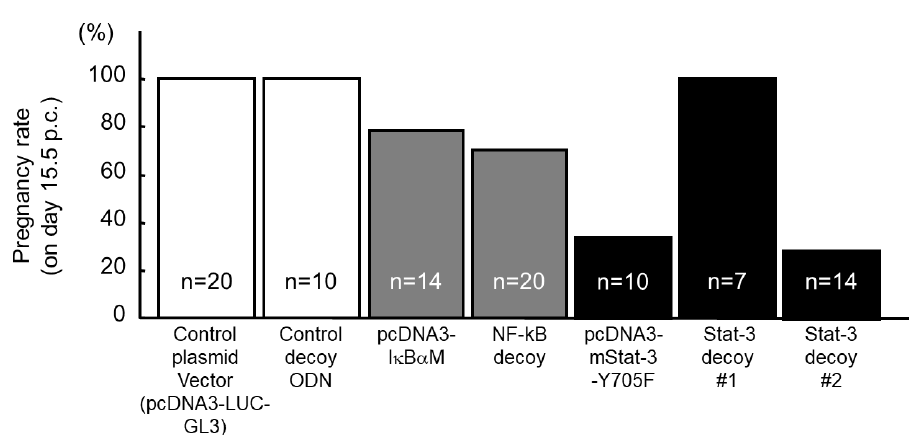
Figure 3. Effect of gene transfer in mouse uterus using HVJ-E vector on pregnancy rate. The dominant negative mutant of NF- κ B (pcDNA3-I κ B α M), the dominant negative mutant of Stat-3 (pcDNA3-Stat-3-Y705F), or double-stranded decoy ODNs (Table 1) were transferred into the uterine cavity using HVJ-E vector on day 1.5 p.c. On day 15.5 p.c., viable fetuses in utero were assessed in each group.